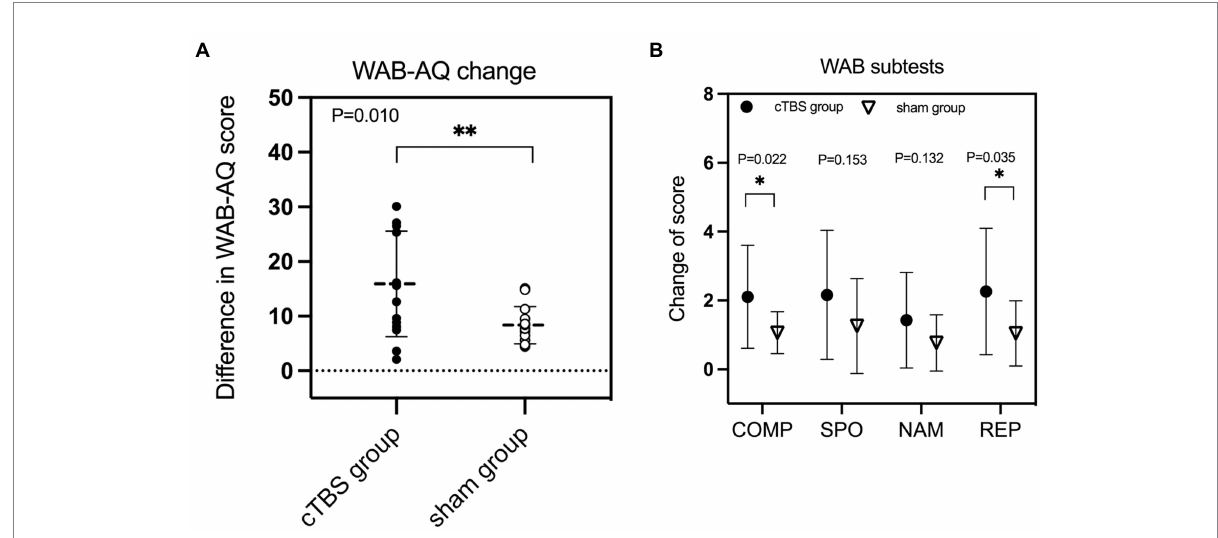
FIGURE 2 The change in the aphasia quotient (AQ) score of the Western Aphasia Battery (WAB) was significantly greater in the continuous theta burst stimulation (cTBS) group than in the sham group (A) . cTBS significantly improved comprehension (COMP) and repetition (REP) performance but not spontaneous speech (SPO) or naming (NAM) performance (B) . *Significant at p < 0.05. ** Significant at p ≤